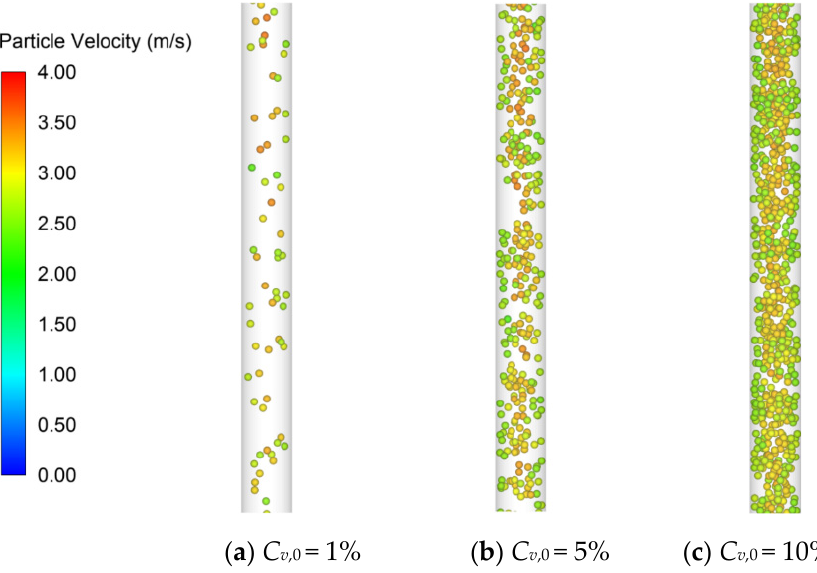
Figure 5. Instantaneous particle velocity distributions at different initial SVFs ( V mix, 0 = 4.0 m/s, d s = 15.0 mm).